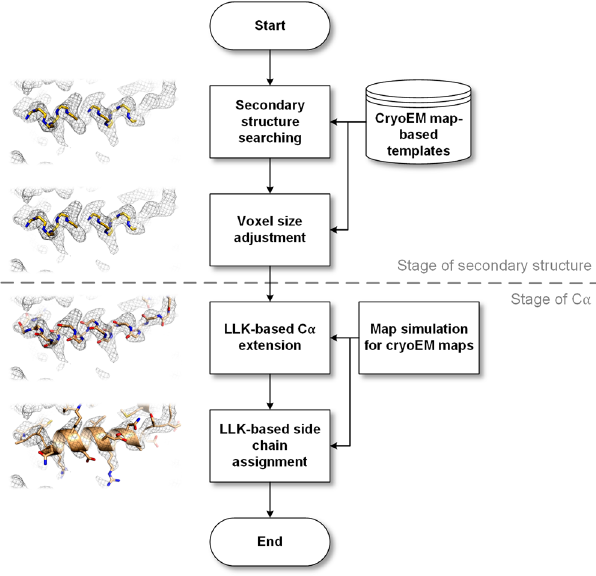
Figure 1. Workflow of EMBuilder. First, the program works on the secondary structure stage. Secondary structure templates are searched and placed in the map. Then, voxel size refinement is performed on these templates. Subsequently, the program works on the C α stage. The reference map is adjusted to the same scale as the working map. The C α target and side chain target functions are created on the basis of the scaled reference map, and then, C α extension and side chain assignment are